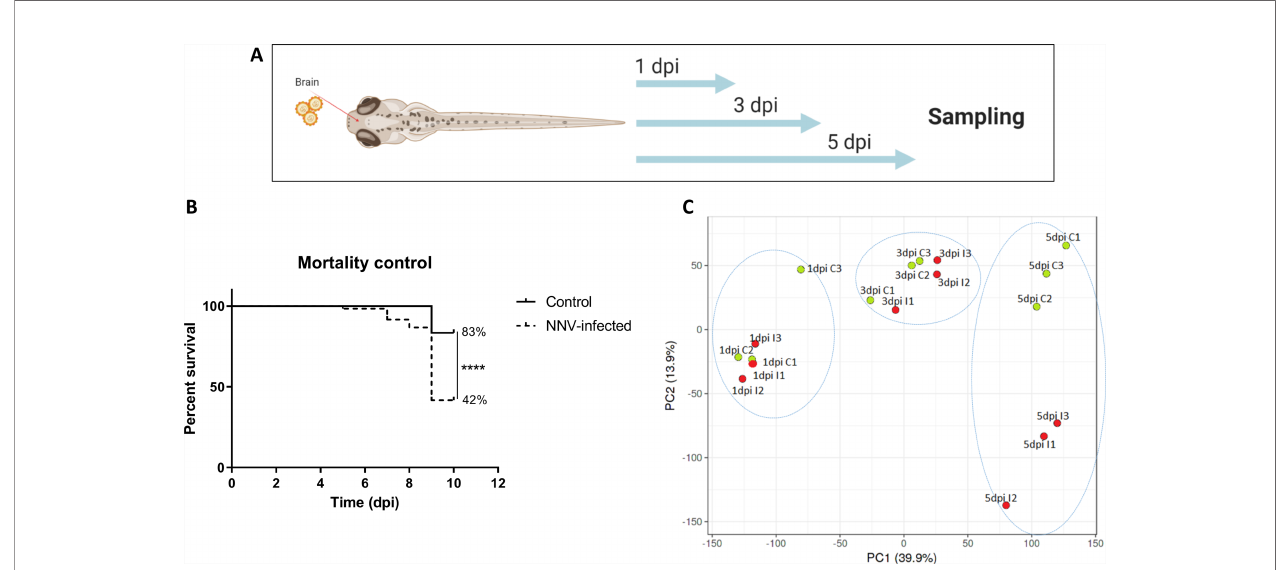
FIGURE 5 | Transcriptome analysis of 3-dpf zebra fi sh larvae infected with NNV via the brain. (A) RNA-Seq experimental design: Zebra fi sh larvae were microinjected via the brain, and three pools of infected and uninfected larvae were sampled at 1, 3, and 5 days postinfection for RNA isolation and Illumina sequencing. (B) Kaplan – Meier survival curves of NNV-infected and uninfected larvae conducted in parallel to RNA-Seq sampling. Statistically signi fi cant differences are displayed as follows: ****, p value < 0.0001. (C) Principal component analysis (PCA) of the